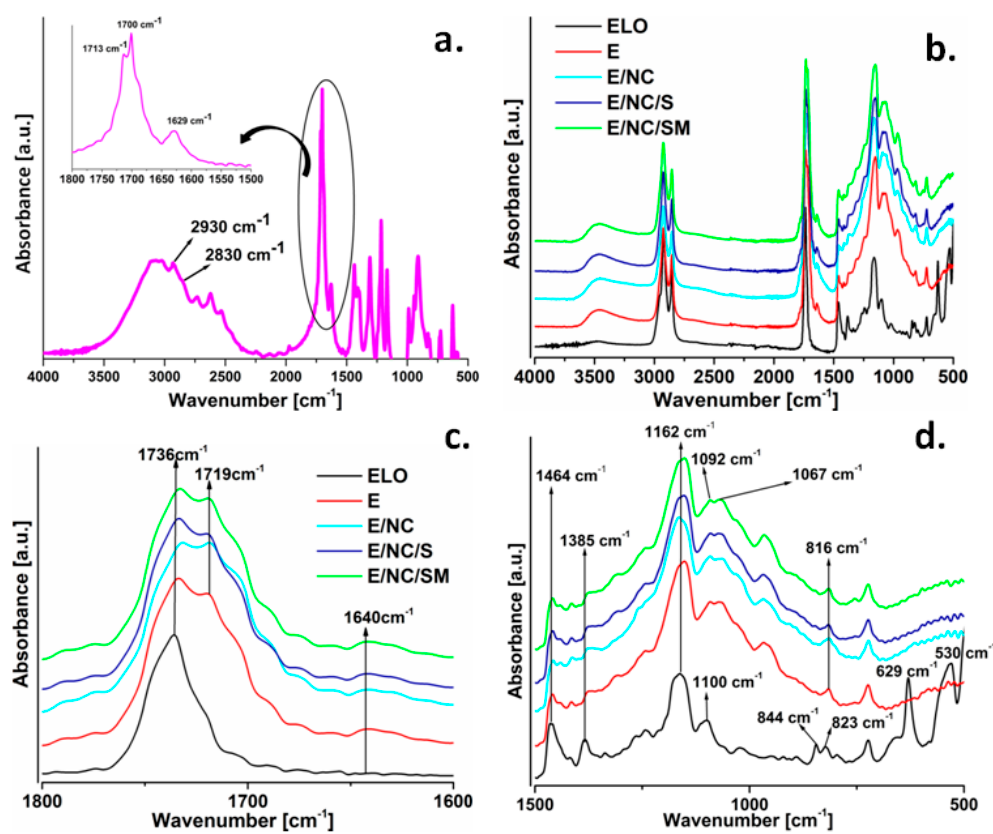
Figure 2. ATR-IR spectra of neat IA ( a ), neat ELO, cured neat epoxy matrix, and epoxy nanocomposites at wavenumber ranges between 4000 cm − 1 and 500 cm − 1 ( b ), 1800 cm − 1 and 1600 cm − 1 ( c ), and 1500 cm − 1 and 500 cm − 1 ( d ).